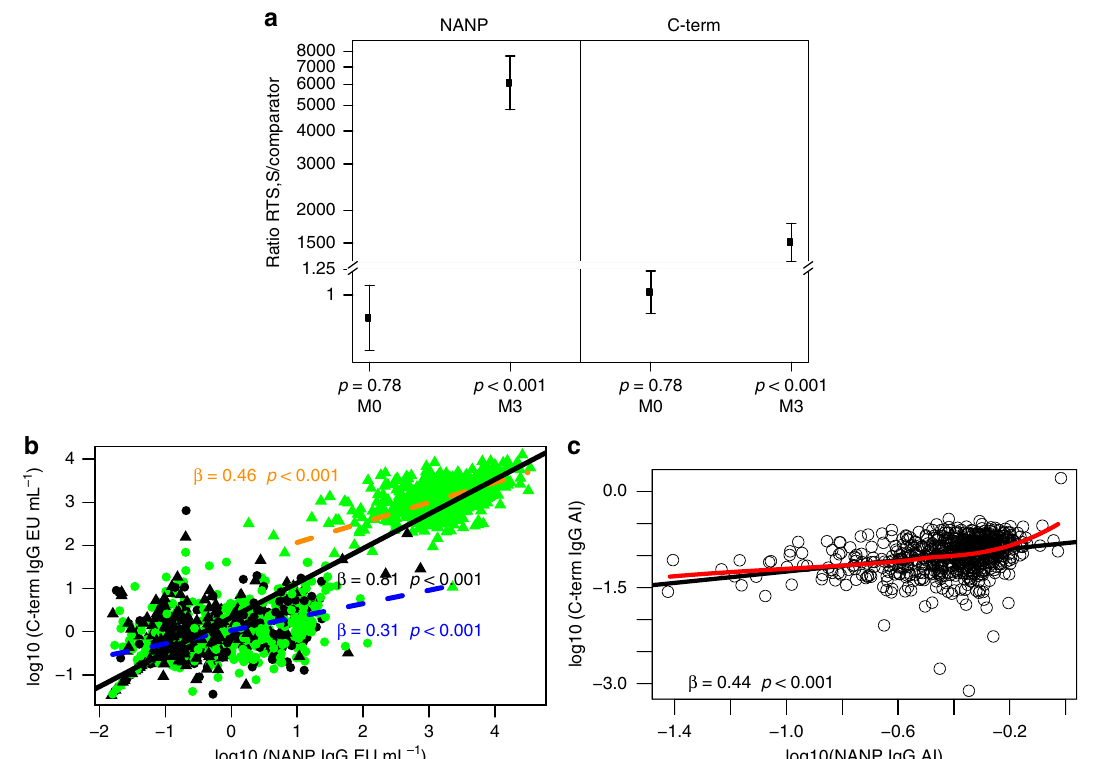
Fig. 1 Effect of RTS,S/AS01E vaccination on anti-CSP IgG responses. a Ratios of mean concentrations (log 10 [EU mL − 1 ]) between RTS,S/AS01E and comparators, before (month [M]0) and after (M3) vaccination, adjusted by site, with adjusted- p -values obtained in linear regression coef fi cients comparing for signi fi cance of logarithm of ratios estimated through mixed models. Error bars represent 95% con fi dence intervals (CI) estimated fi tting the mixed model. b Correlations between CSP NANP and C-terminus (C-term) IgG concentrations. Regression lines with scatterplots show the association among: (i) all subjects pre-vaccination and post-vaccination in a dashed orange line ( r = 0.93; 95% CI = 0.93, 0.94); (ii) comparator vaccinees pre-vaccination (black circles) and post-vaccination (black triangles) and RTS,S/AS01E pre-vaccination (green circles) ( r = 0.48; 95% CI = 0.42, 0.54) in a solid black line; (iii) RTS,S/AS01E post-vaccination (green triangles; r = 0.66; 95% CI = 0.62, 0.70) in a solid green colour line. c Correlations between CSP NANP and C-term IgG avidity index (AI). Only samples with IgG concentration above the assay lower limit of quanti fi cation